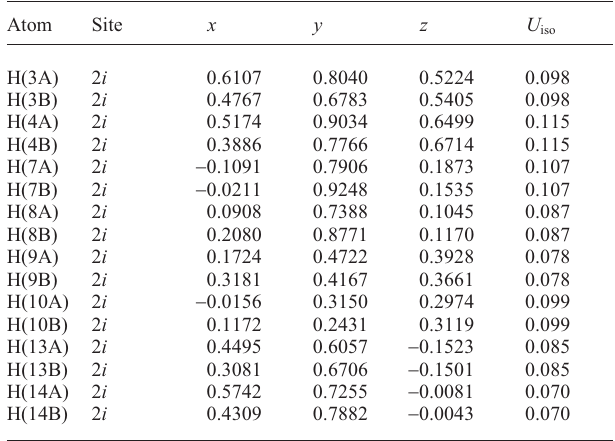
Table 2. Atomic coordinates and displacement parameters (in Å 2 )